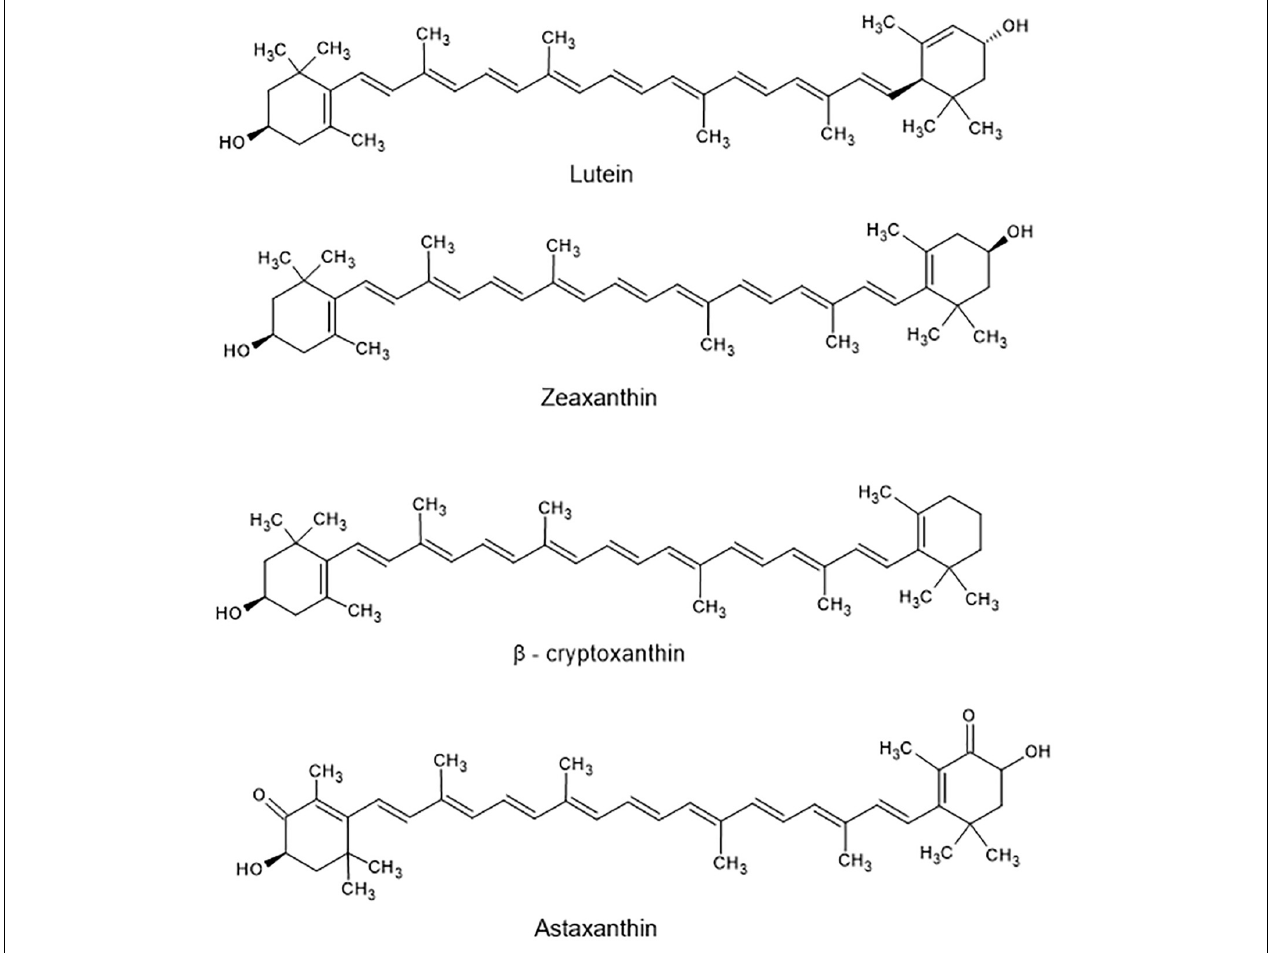
FIGURE 3 | Structure of main xanthophylls found in